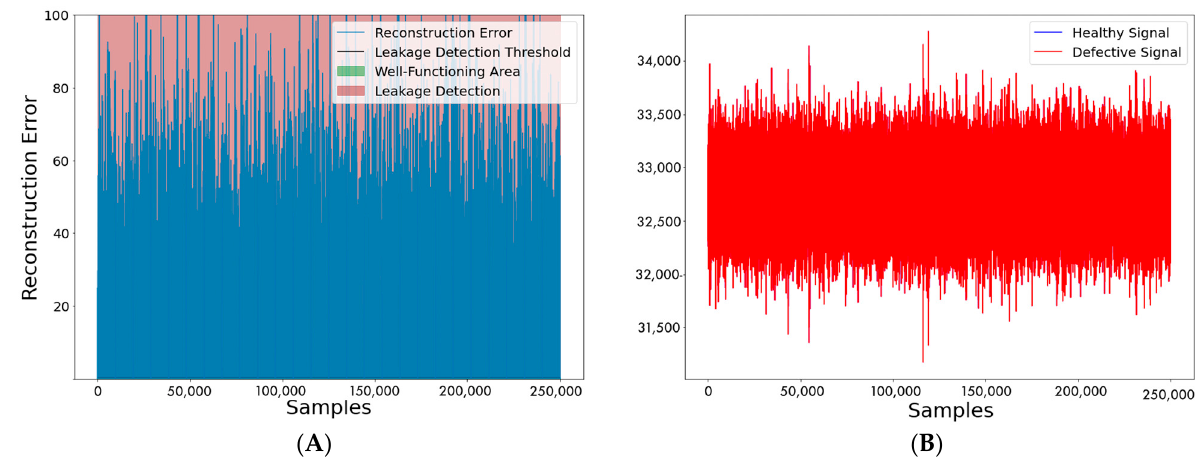
Figure 12. ( A ): The acoustic signal. With blue, the healthy signal is represented, and with red the signal after the leakage. ( B ): Reconstruction Error of the LSTM autoencoder.